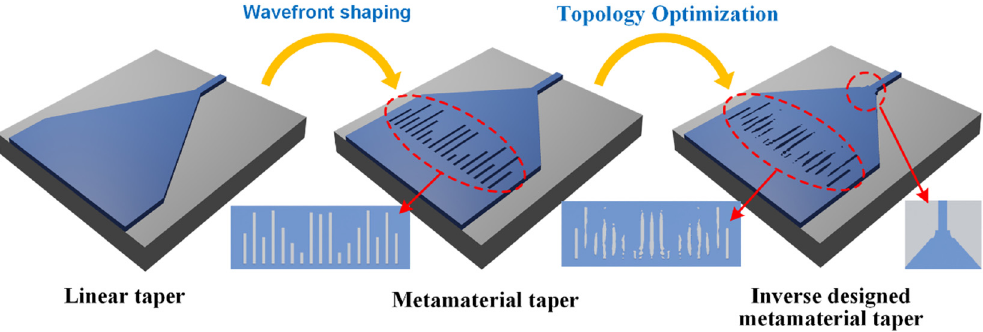
Figure 1: Hierarchical design scheme of ultra-short metamaterial mode-size converter.